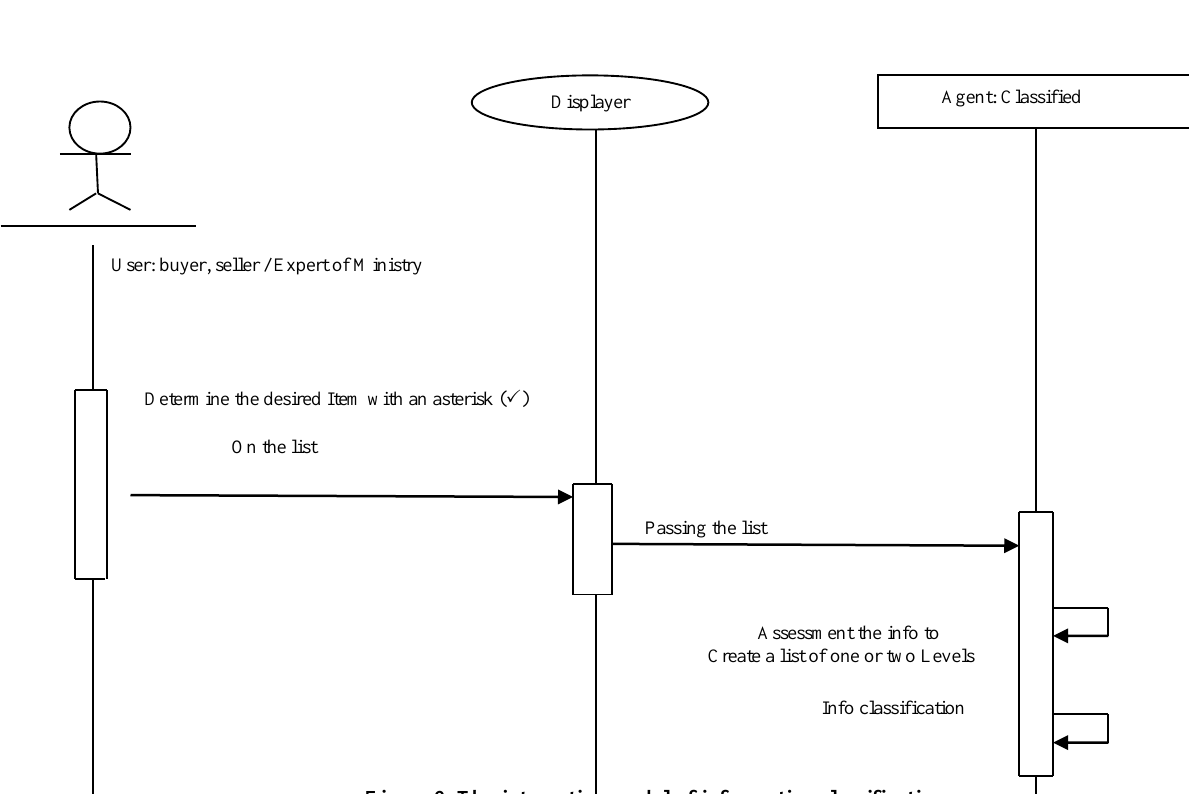
Figure 9. The interaction model of information